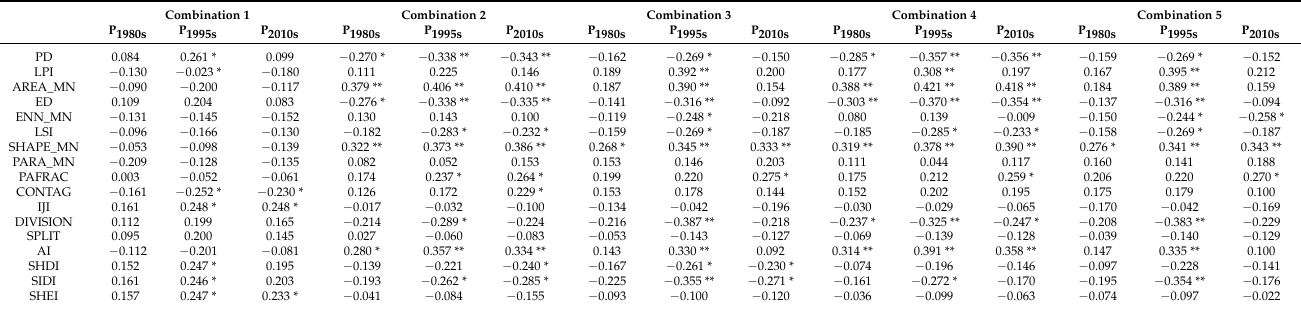
Table 5. The correlation between landscape metrics and soil erosion under five different